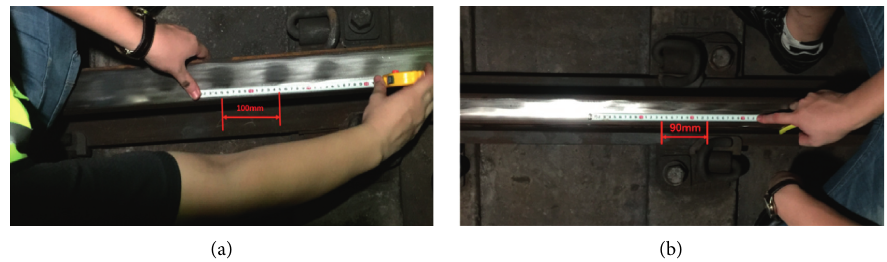
Figure 10: The typical corrugation of the downward curve of Shi-Pan Station. (a),